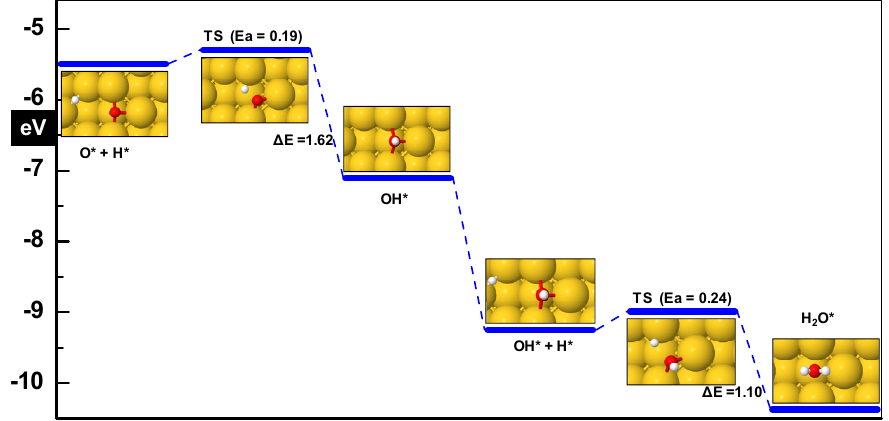
Figure 6. Water formation on the Au(310) surface from adsorbed O and H. Zero energy corresponds to gas phase O, H and the clean